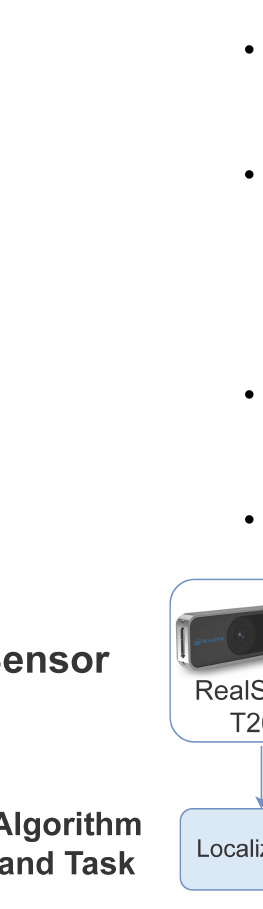
Figure 6. Sensors employed on the Marvin robotic platform, associated with the corresponding task they